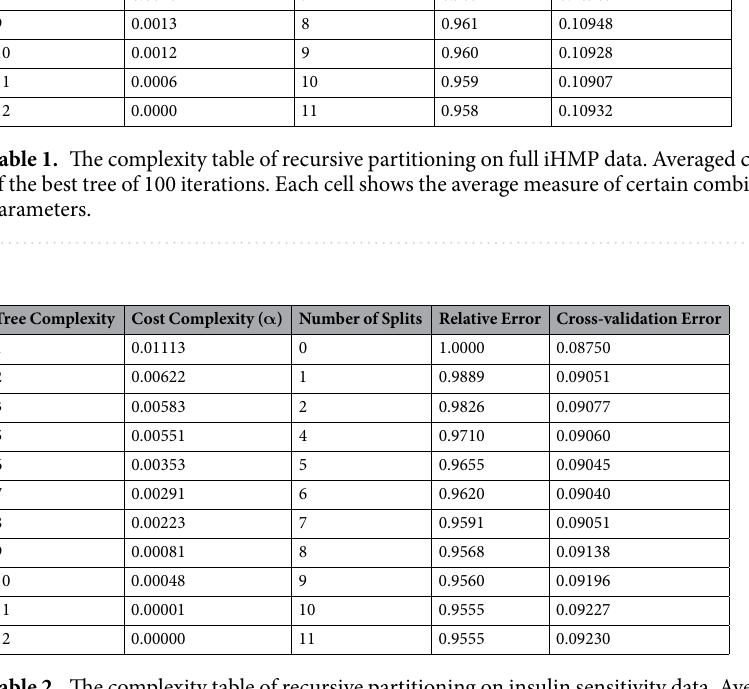
Table 2. The complexity table of recursive partitioning on insulin sensitivity data. Averaged misclassification error rate of the best tree of 100 iterations. The number in each cell is expressed as a